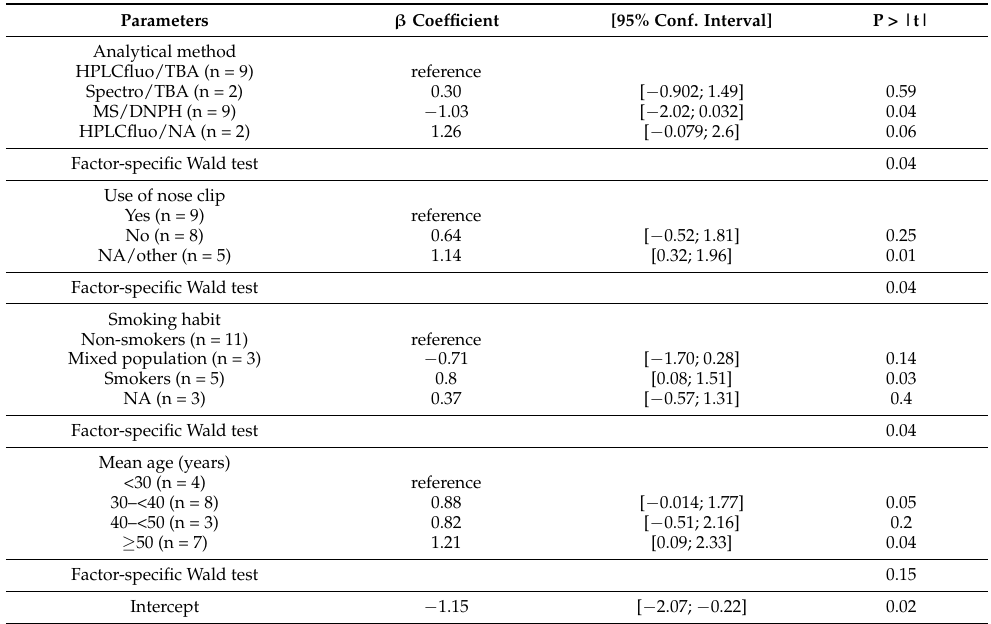
Table 2. Mixed effects regression analysis according to analytical method, use of nose clip, smoking status, and age category.